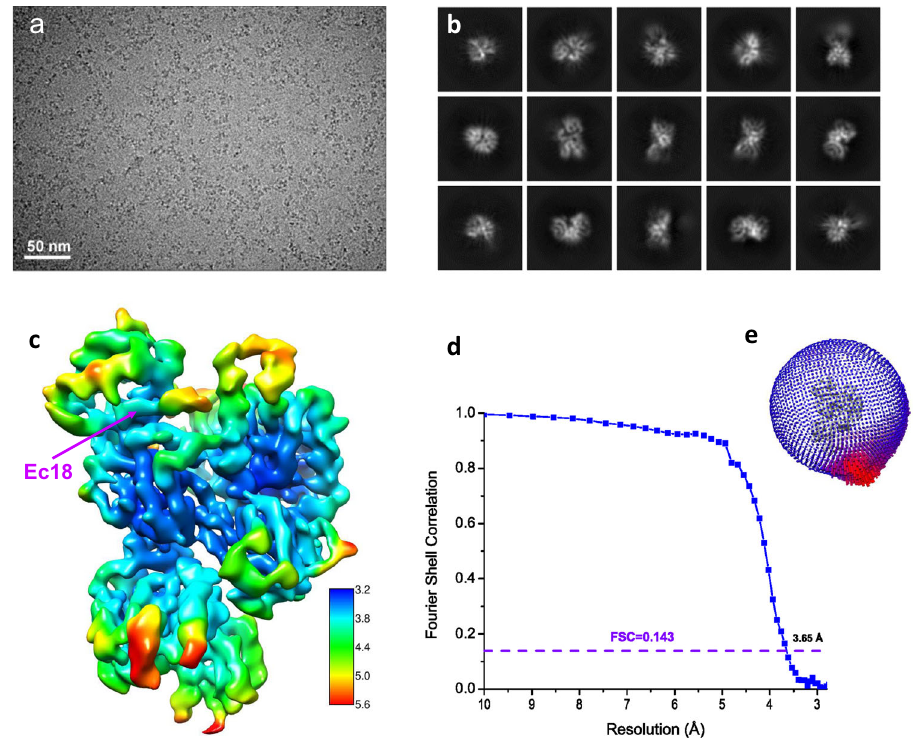
Fig. 1 Structure determination by single-particle cryo-EM. a A typical motion-corrected cryo-EM micrograph from a total of 12,826 micrographs. b 2D class averages. c Reconstructed map colored with local resolutions. d Fourier shell correlation (FSC) curve for the 3D reconstruction to determine the structure resolution. e Orientation distribution for particles used in 3D